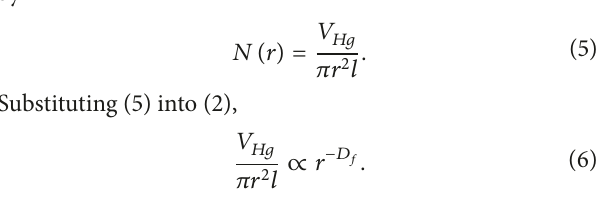
Table 3: The fractal dimensions of entire pores using different fractal